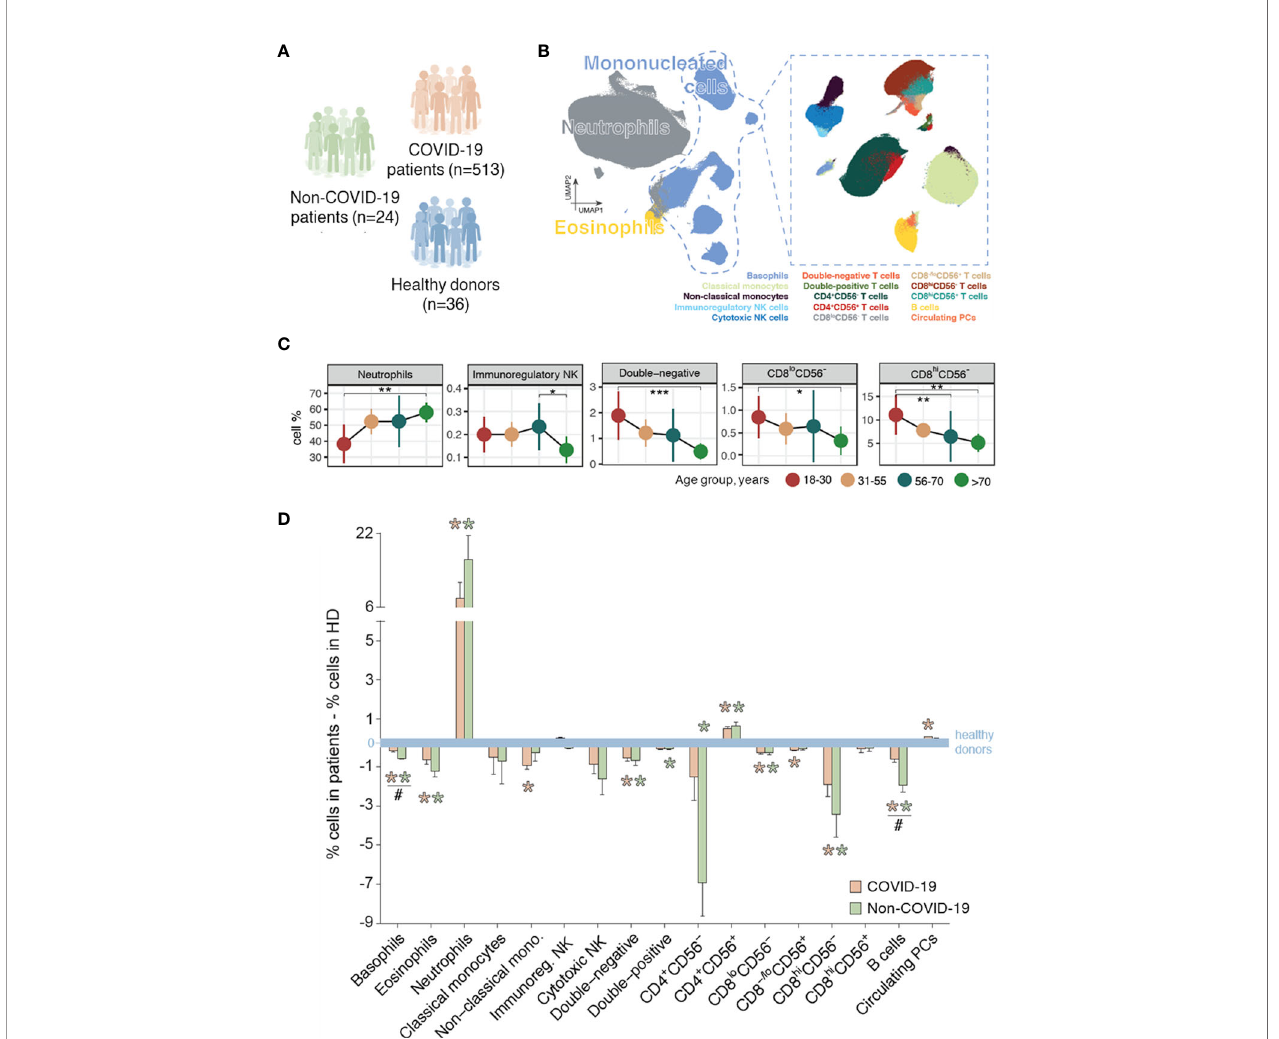
FIGURE 1 | Immune pro fi ling of patients with COVID-19, patients with non-SARS-CoV-2 infections, and healthy donors (HDs). (A) Immune pro fi ling was performed using multidimensional fl ow cytometry in a training series of 513 patients with COVID-19, 24 patients with other infections, and 36 HDs. (B) Schematic representation of the 17 immune cell-types systematically identi fi ed through unbiased and semi-automated analysis in peripheral blood (PB) samples from all subjects included in the study (n=573). (C) Immune cell-type percentages in PB samples of HDs by age group (18 – 30 years, n=8; 31 – 55 years, n=8; 56 – 70 years, n=11; >70 years, n=9) for cell-types with signi fi cantly different levels across age groups. * P <0.05; ** P <0.01; *** P <0.001 in all panels. Statistical signi fi cance was evaluated using the Kruskal – Wallis test, with multiple testing corrected using the Holm method. (D) Immune response in patients with COVID-19 (n=513) and in patients with other infections (n=24), illustrated as the variations in the median percentages of each cell-type versus the median values in age-group-matched HDs (n=36, blue line). Orange asterisks indicate signi fi cant differences between patients with COVID-19 and HDs, and green asterisks indicate signi fi cant differences between patients with other infections and HDs. Hash symbols (#) indicate signi fi cant differences between patients with COVID-19 and patients with other infections ( P <0.05). Statistical signi fi cance was evaluated using Mann-Whitney